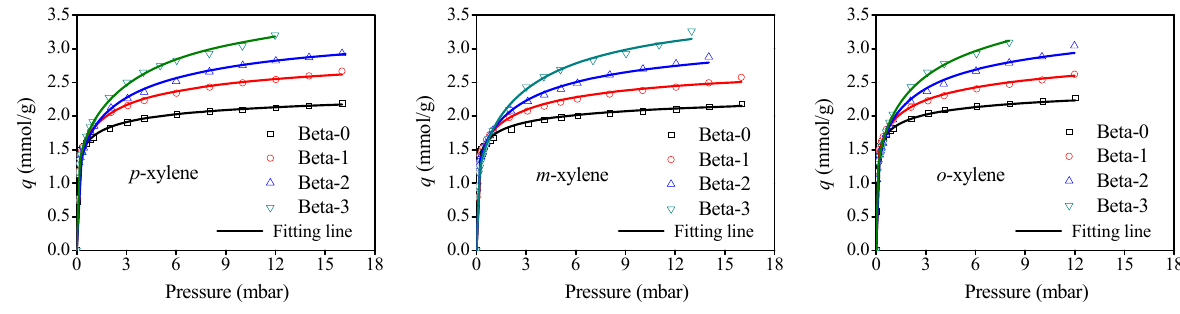
Figure 4. Adsorption isotherms of xylene isomers on Beta zeolite samples at 308